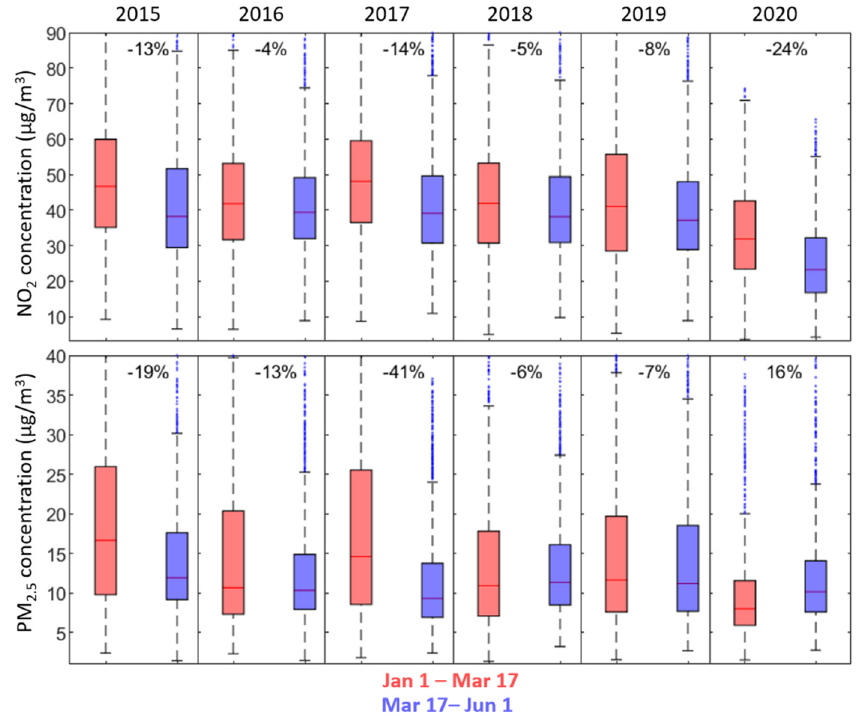
Figure 1. Statistical distribution of NO 2 (upper panels) and PM 2.5 (lower panels) concentrations ( µ g/m 3 ) measured by Airparif over Paris for the 1 January to 17 March (17 March to 1 June) time period in red (blue) from 2015 to 2020 (left to right panels). The medians and the quartiles are represented by center lines and borders of the boxes, respectively. The outliers are indicated in blue points. Numbers are the percentage of concentrations change between 17 March–1 June and 1 January–17 March time periods. Table 1. Periods identified as particulate pollution episodes over Paris in the frame of the present study, along with associated mean and 1- σ standard deviation of PM 2.5 , NH 3 , and major PM 1 chemical species (OM: organic matter, SO 42 − : sulfate, NO 3 − : nitrate, and NH 4+ : ammonium) concentrations ( µ g/m 3 ). Event # Date PM